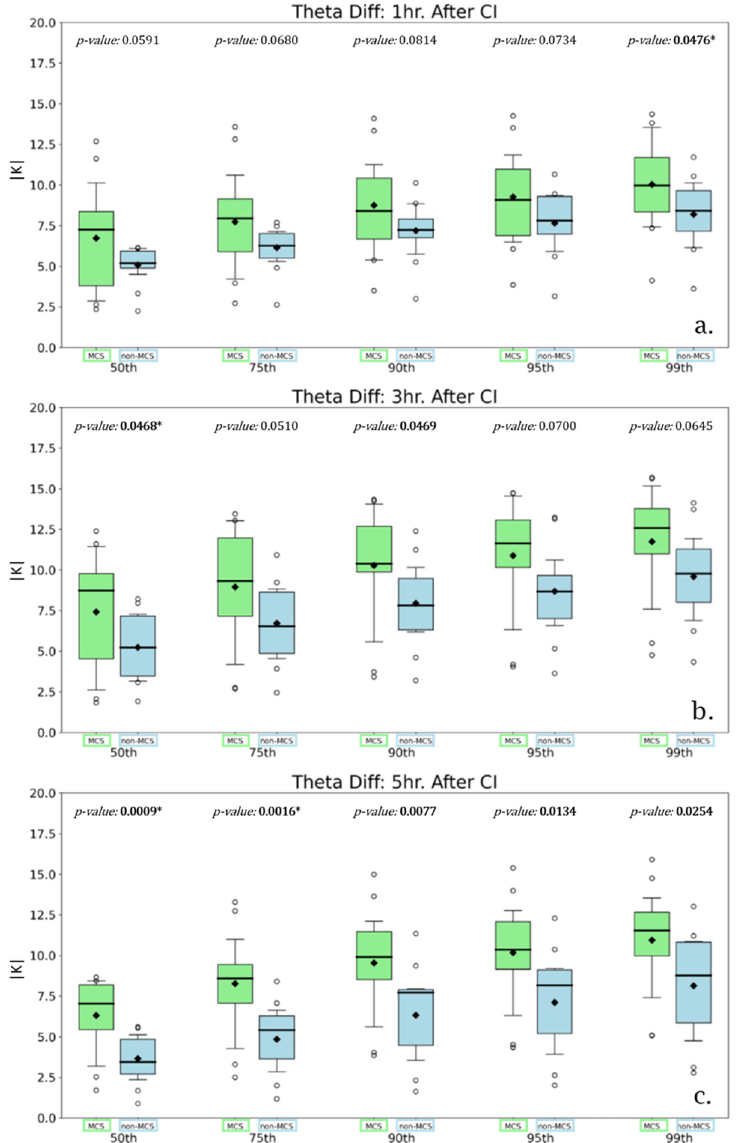
Figure 4. As in Figure 3, but for theta difference ( Δ θ ). Units in Kelvin.